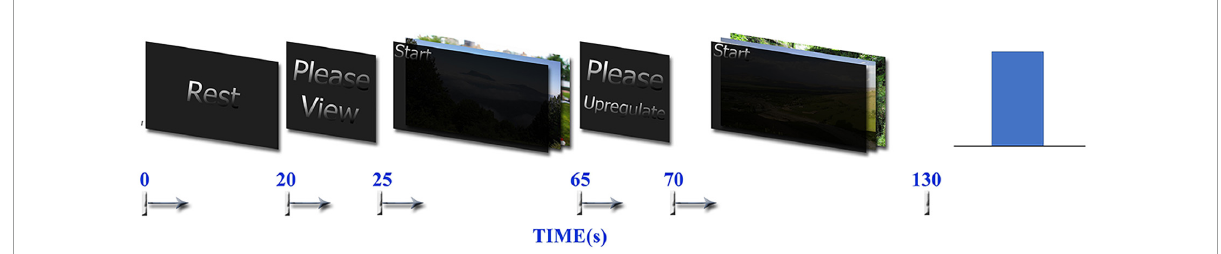
FIGURE1 Neurofeedback bar and timing of the tasks used in the one run of neurofeedback protocol, which contains Rest, View, and Upregulation blocks.